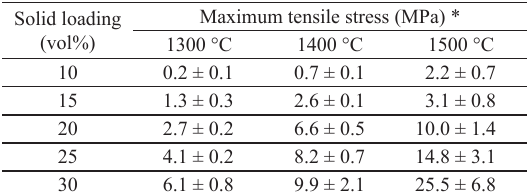
Figure 5. (a) Maximum tangential stress achieved in all samples during the O-ring tests, and (b) observation of the fragments from test sample after Table 1. Maximum tensile stresses (MPa) assessed in the O-ring diametral compression tests 26 by the equation developed by Martinez et al. 18 .